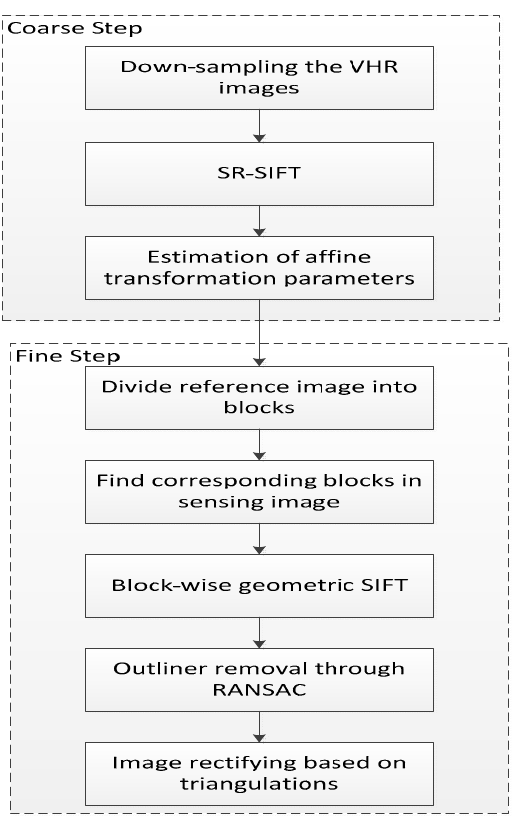
Figure 1. Flowchart of the proposed method.